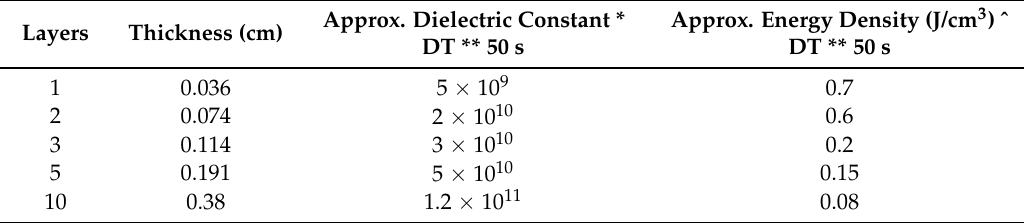
Table 1. Dielectric and Energy Density as a function of number of layers for 50 s DT.